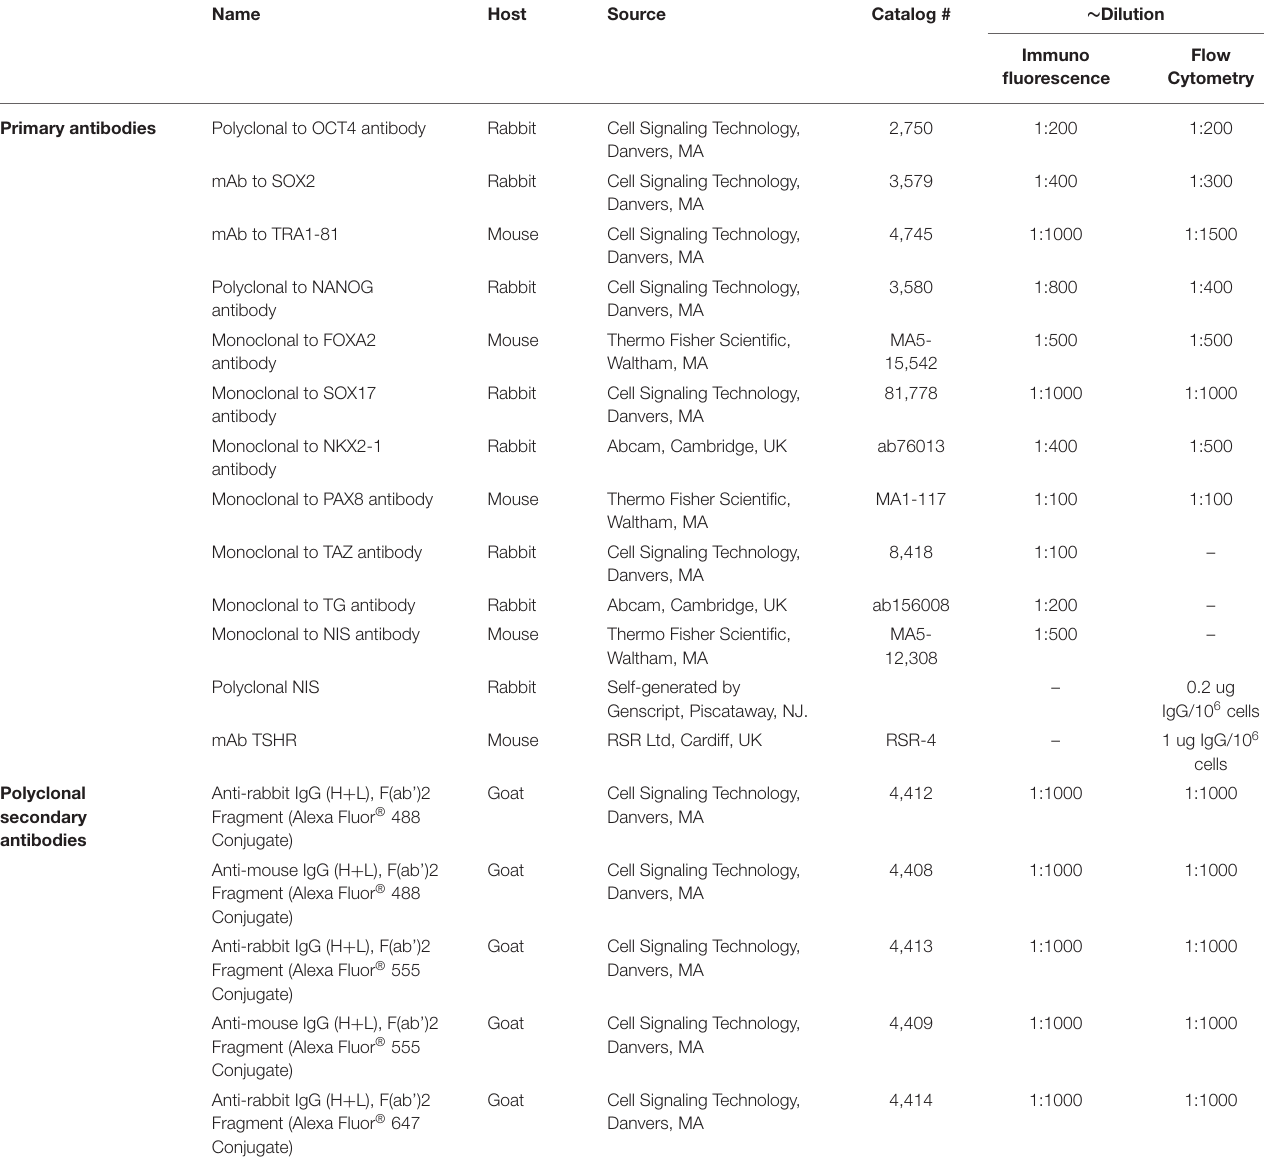
TABLE 1 | Antibodies used in the described